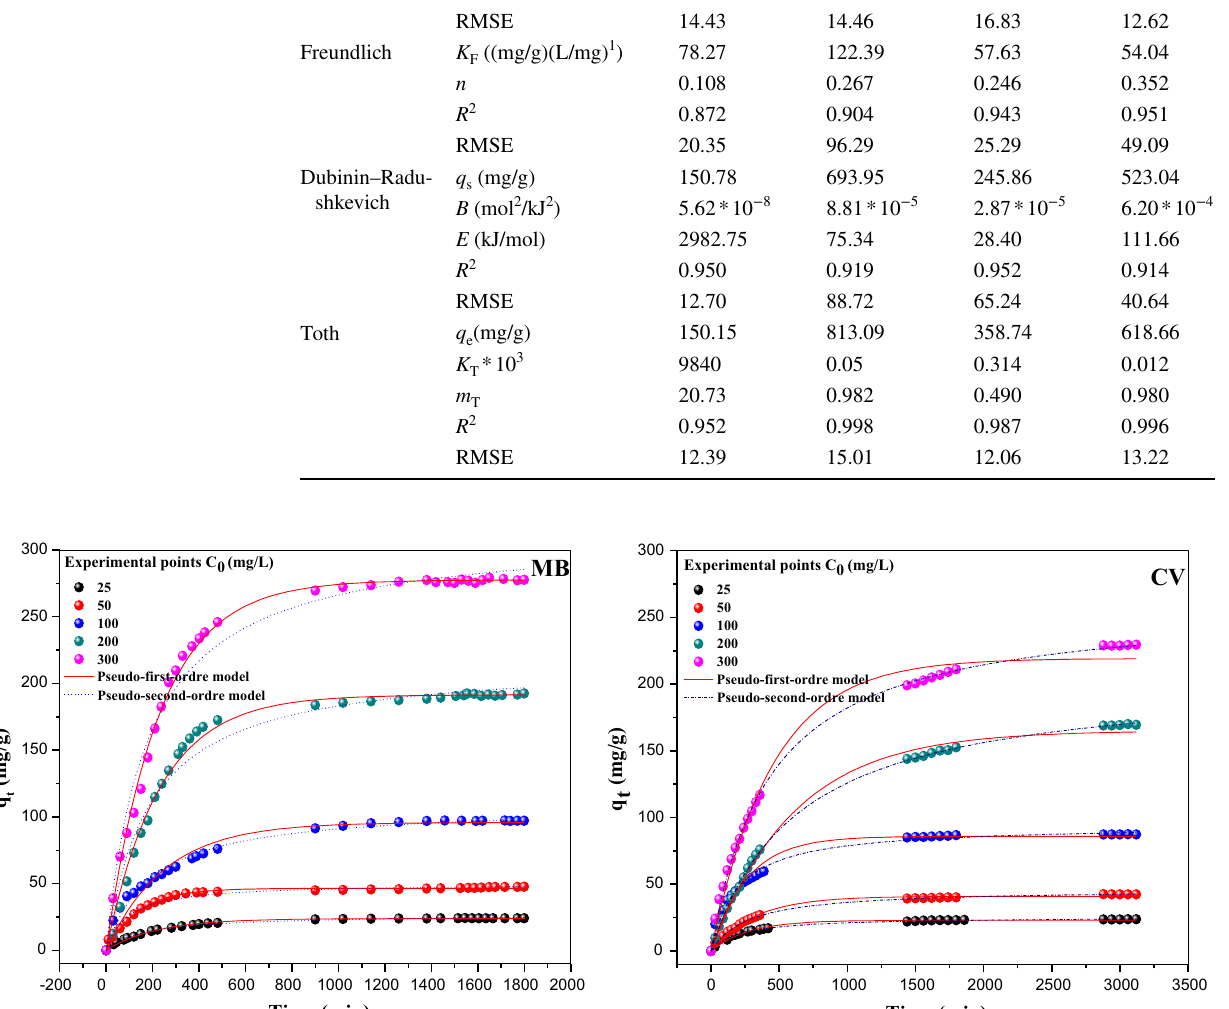
m = 100 mg, V = 100 0 = 25–300 mg/L,